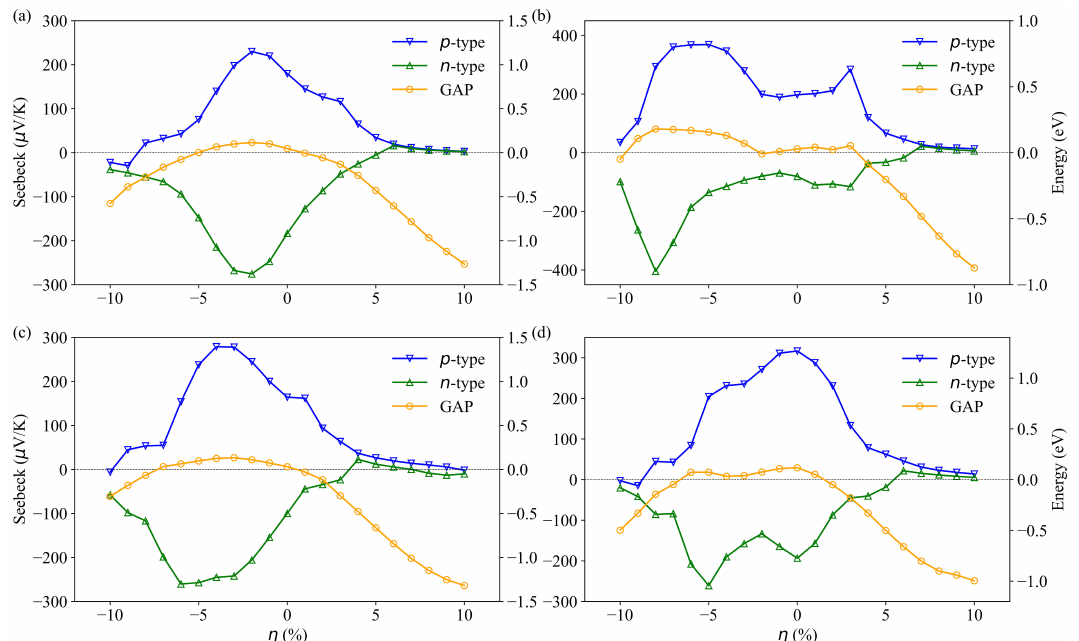
Figure 6. Maximum Seebeck coefficient and band-gap energy of Bi 2 Te 3 ( a ), PbBi 2 Te 4 ( b ), PbBi 4 Te 7 ( c ) and Pb 2 Bi 2 Te 5 ( d ) vs. strain at 300 K. The blue and green lines correspond to the Seebeck coefficient for p -type and n -type doping, respectively. The charge carrier concentrations range from 10 17 to 10 22 cm − 3 . The orange lines correspond to the band-gap